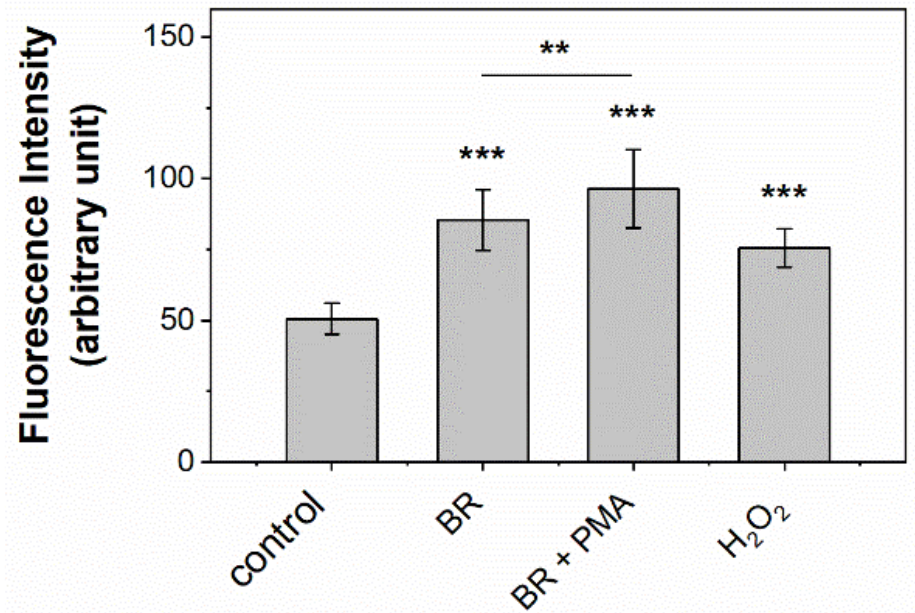
O as detected by a H O -specific fluo- 2 2 2 2 O (500 μM) was used as the positive 2 2